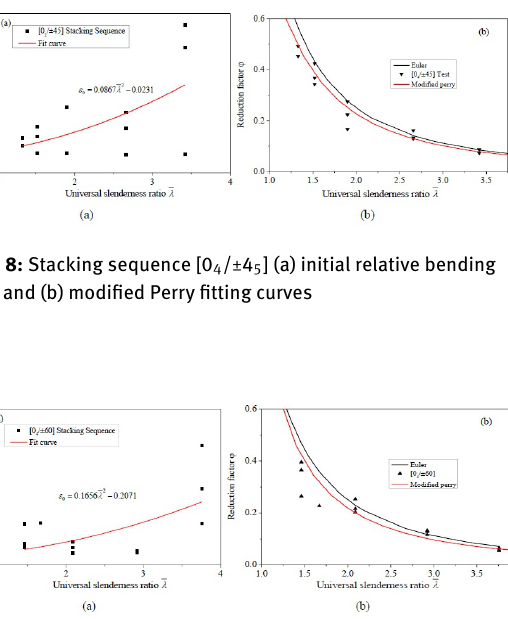
Figure 9: Stacking sequence [0 4 /60 2 ] (a) initial relative bending